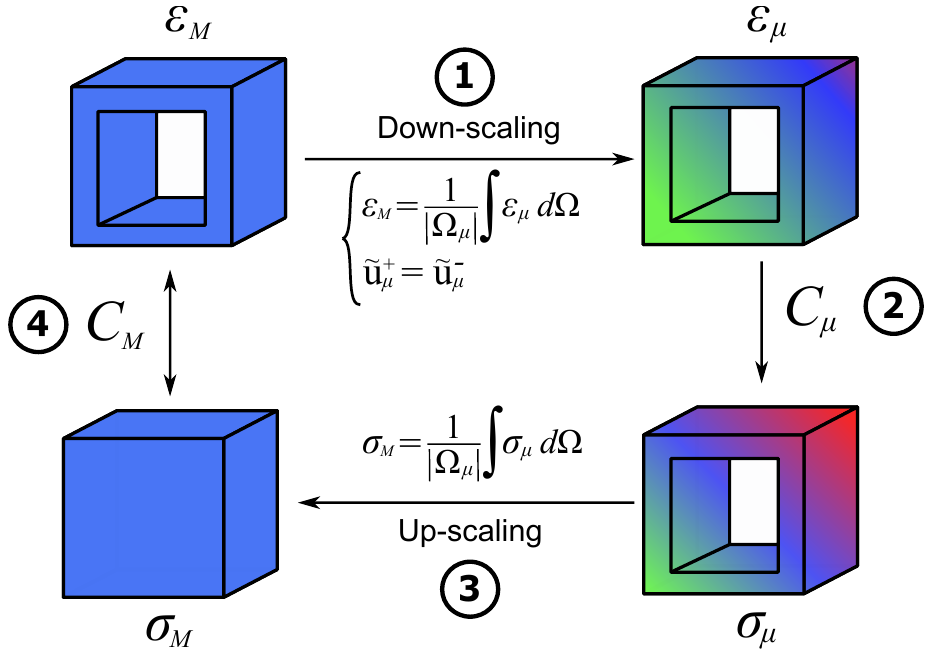
Figure 7. Homogenization